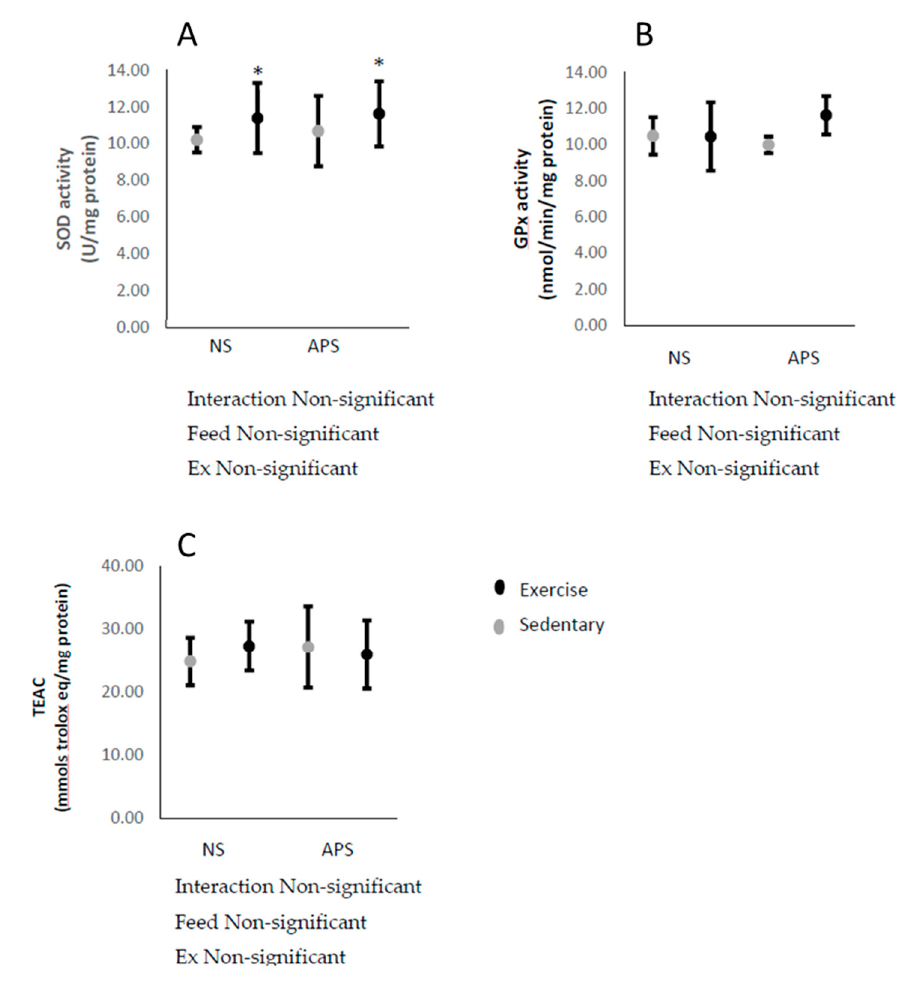
Figure 5. Means ± SEM: ( A ) skeletal muscle SOD (control, n = 6; APS, n = 6; Ex, n = 6; Ex + APS, n = 6), ( B ) GPx (control, n = 6; APS, n = 7; Ex, n = 6; Ex + APS, n = 6), and ( C ) TEAC (control, n = 6; APS, n = 5; Ex, n = 6; Ex + APS, n = 6). NS: non-supplemented groups, APS: acacia polyphenol-supplemented groups. * p < 0.05, main effect for exercise. A two-way analysis of variance (ANOVA) was performed to identify the main effect of supplement and/or exercise.